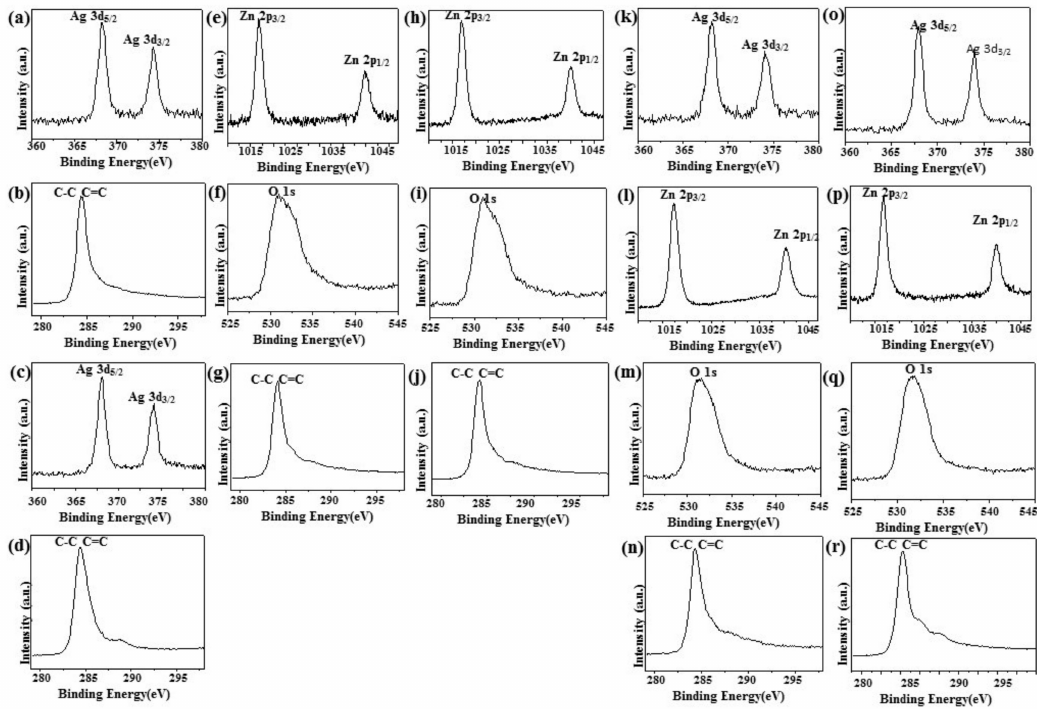
Figure 4. X-Ray photoelectron spectroscopy. X-Ray photoelectron spectroscopy (XPS) analysis of ( a , b ) 5.34% Ag / rGO, ( c , d ) 7.49% Ag / rGO, ( e – g ) 6.85% ZnO / rGO, ( h – j ) 16.45% ZnO / rGO, ( k – n ) 3.47 / 34.91% Ag / ZnO / rGO, and ( o – r ) 7.08 / 15.28% Ag / ZnO /